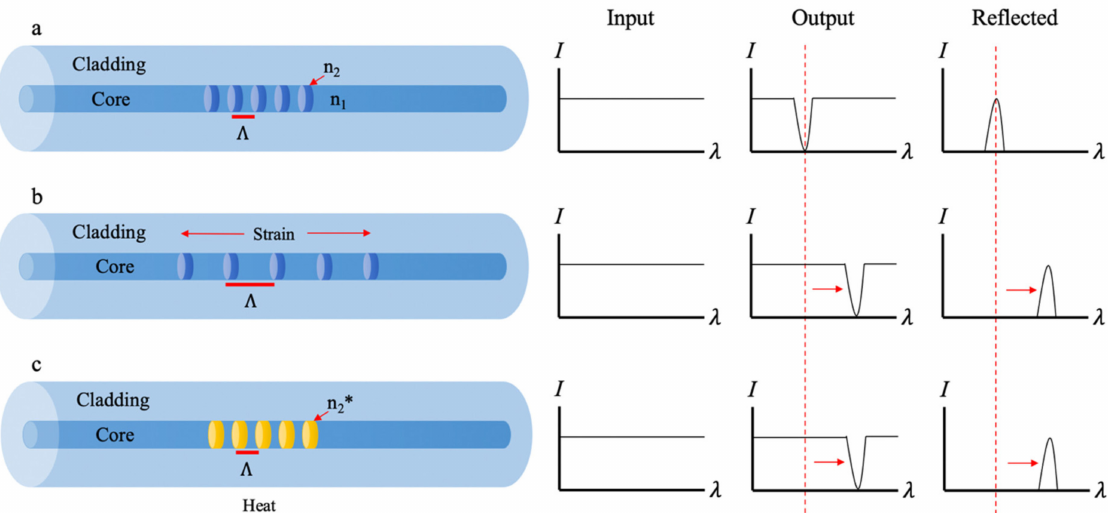
Figure 5. Schematic of FBG measuring modes. The physical changes during strain and heating of a FBG are shown with their respective input, output and reflected light spectra. A FBG with no strain and ambient heat will have a specific output and reflected profile ( a ); as strain is applied the grating spacing will change causing a shift in the output and reflected profile ( b ); and if heat is applied the effective refractive index of the gratings (n 2 *) will change causing a shift in the output and reflected profile and changes in the spacing between the grating will also occur due to thermal expansion ( c ).